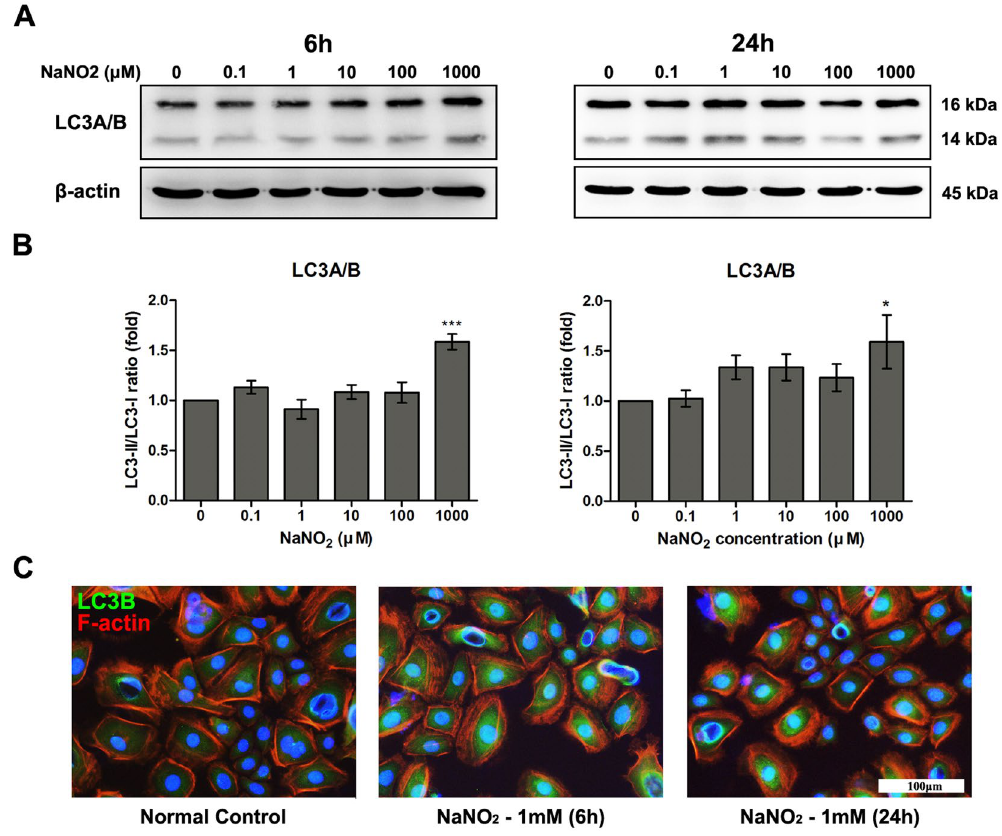
Figure 3. Effect of NO on autophagy of HCEC. The expression levels of autophagy signal, LC3A/B proteins were measured by western blot analysis ( A ). The inactive I form is 16 kDa and the active II form is 14 kDa. Relative densitometry ( B ) was calculated as a percentage of the control, and all values (mean ± SEM) were obtained from three independent experiments; each independent experiment was performed in triplicate ( * p < 0.05, *** p < 0.001). The increased LC3B expression (shown in green) resulting from high a concentration (1 mM) of NaNO 2 was demonstrated with immunocytochemical assay after 6 and 24 h incubation ( C ). Full size images of blots are available in the Supplementary